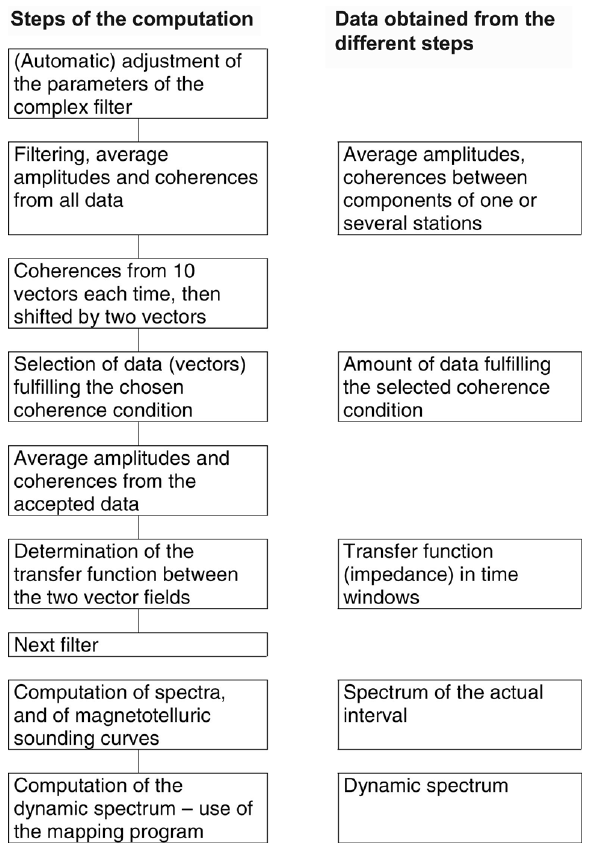
Fig. 1. Scheme of the program used in the data processing and the results obtained by this program used in the study (Ver ő 1972).